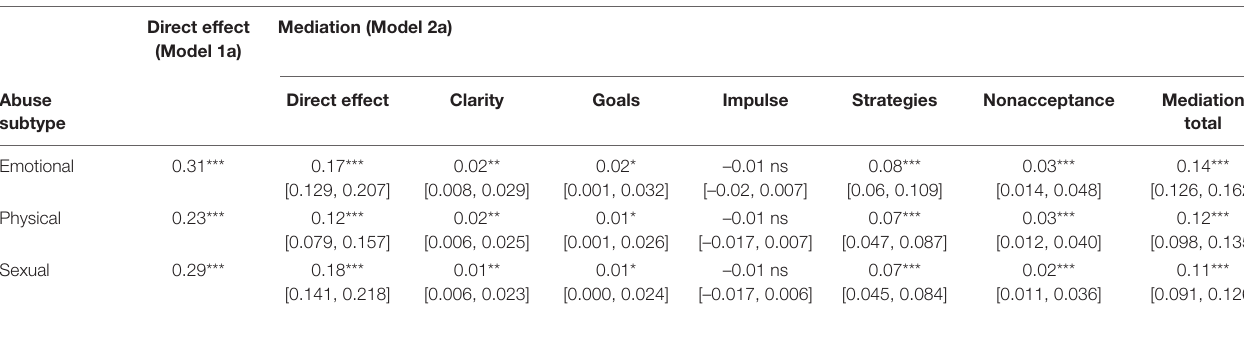
FIGURE 2 | Model 2a: Sub-factors of DERS-16 as mediators of the relationship between childhood abuse and NSSI. TABLE 5 | Effects with and without mediation (Models 1a and